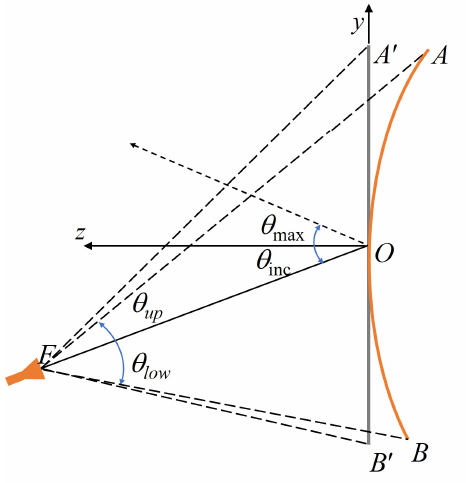
Figure 1. Side view of an off-set convex reflectarray.